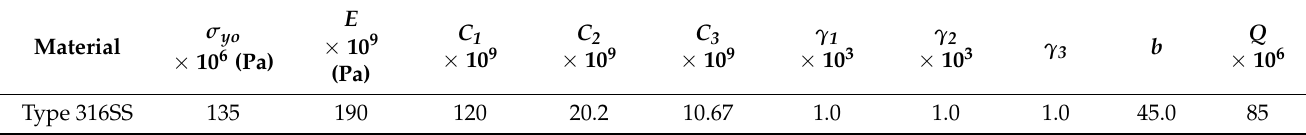
Table 9. Material constants for inelastic material